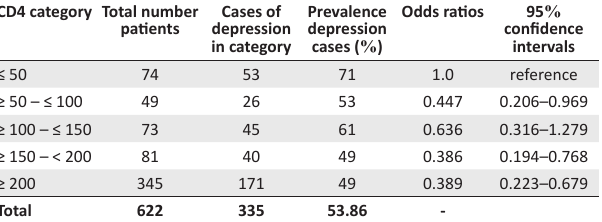
TABLE 5: Relationship between CD4 count and cases of depression.